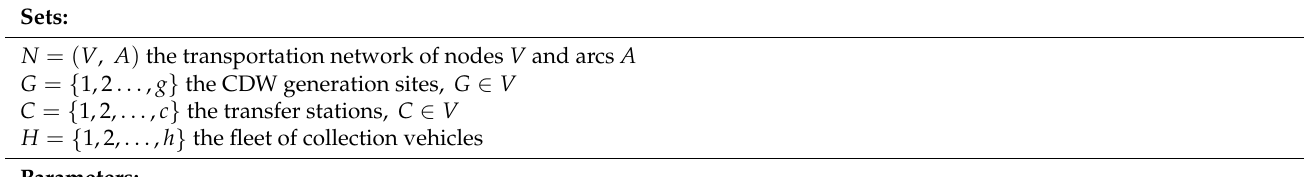
Table 1. Related notations for pr01 benchmark